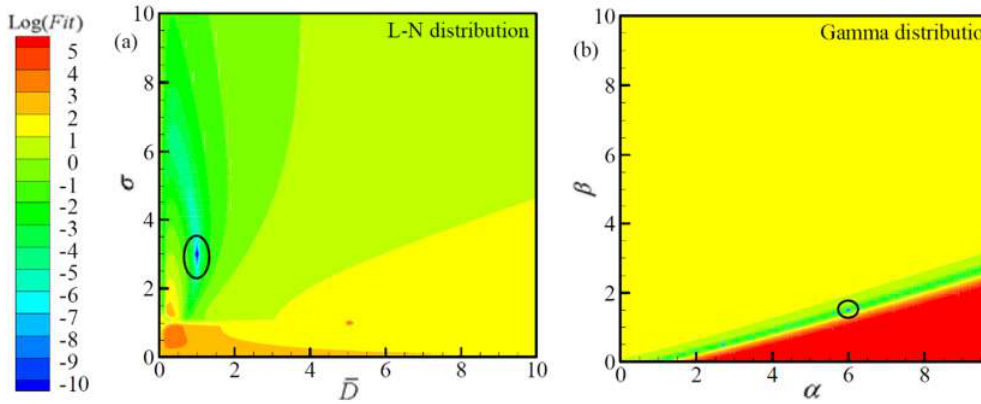
Figure 6. Distribution of the objective function values for different ASDs by using the SEM: ( a ) L-N distribution; ( b ) Gamma distribution.